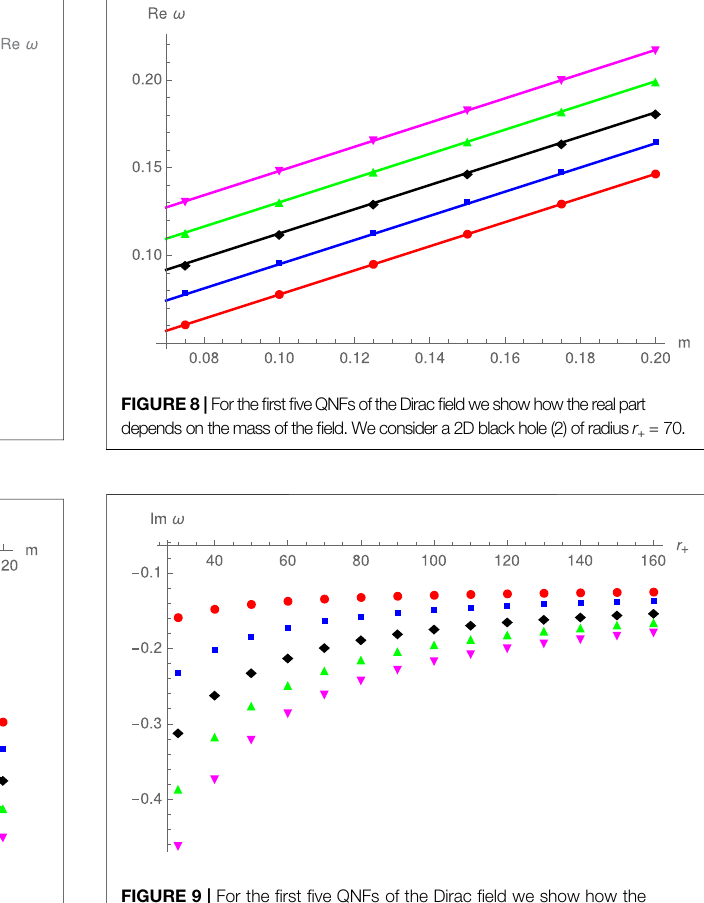
TABLE 5| For theDirac fi eld wegive thelinear fi tsfor the points shown in Figures 7 , 8 . We take r + (cid:1) 70. Mode number Linear fi t for Im ( ω )